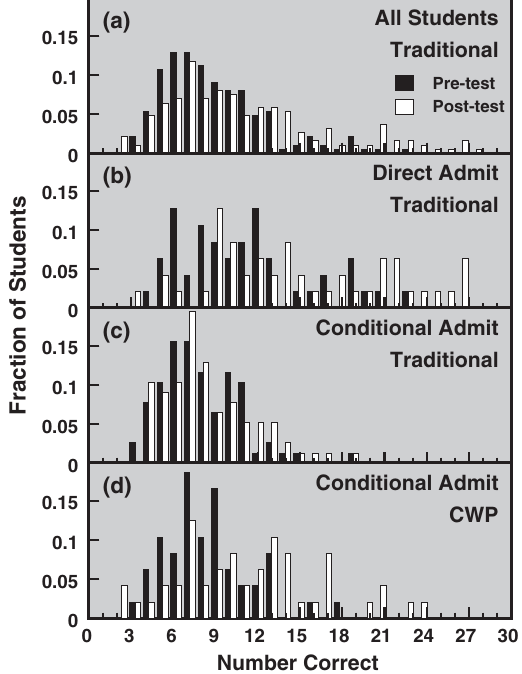
FIG. 3. Histogram of pretest (black) and post-test (white) Force Concept Inventory data. (a) FCI data from all traditionally taught students. (b) Data from all traditionally taught, directly admitted students. (c) Data from all traditionally taught, conditionally admitted students. (d) Data from all conditionally admitted students taught in the CWP